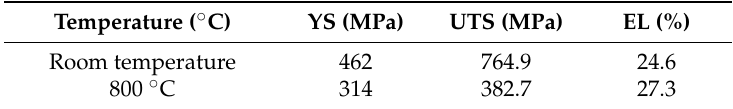
Table 2. The results of tensile tests on Alloy 617 weldments.